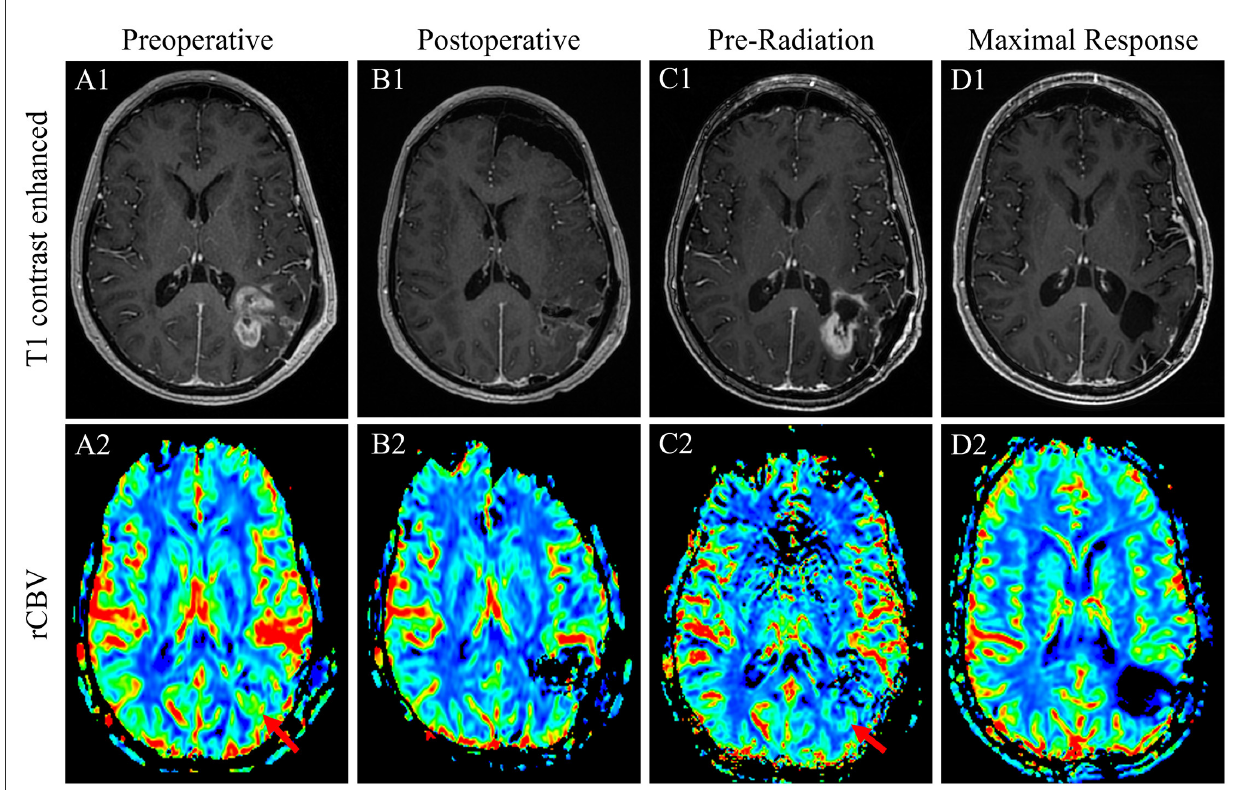
FIGURE1 T1-weighted contrasted sequences (1) and relative cerebral blood volume MRI sequences of case 1 patient’s GB at the time of initial regrowth and presentation to our facility before the re-resection of the de novo disease (A) ; immediately postoperative result after a near-gross total re-resection (B) ; 1 week prior to the initiation of chemoradiation with substantial interval disease regrowth appreciated (C) ; and the time of maximal response with complete disease remission of 6 weeks after the conclusion of radiation therapy and after one cycle of adjuvant TMZ (D)